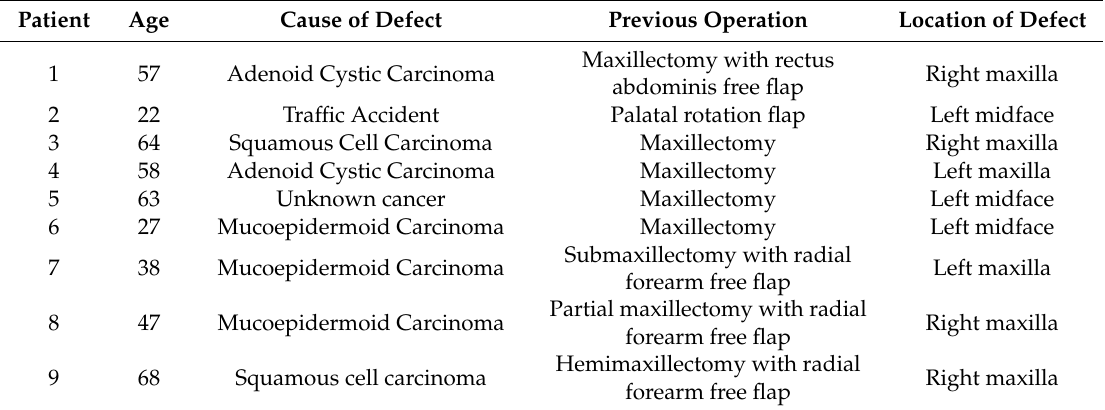
Table 1. Clinical data of enrolled patients with reconstruction of palatomaxillary